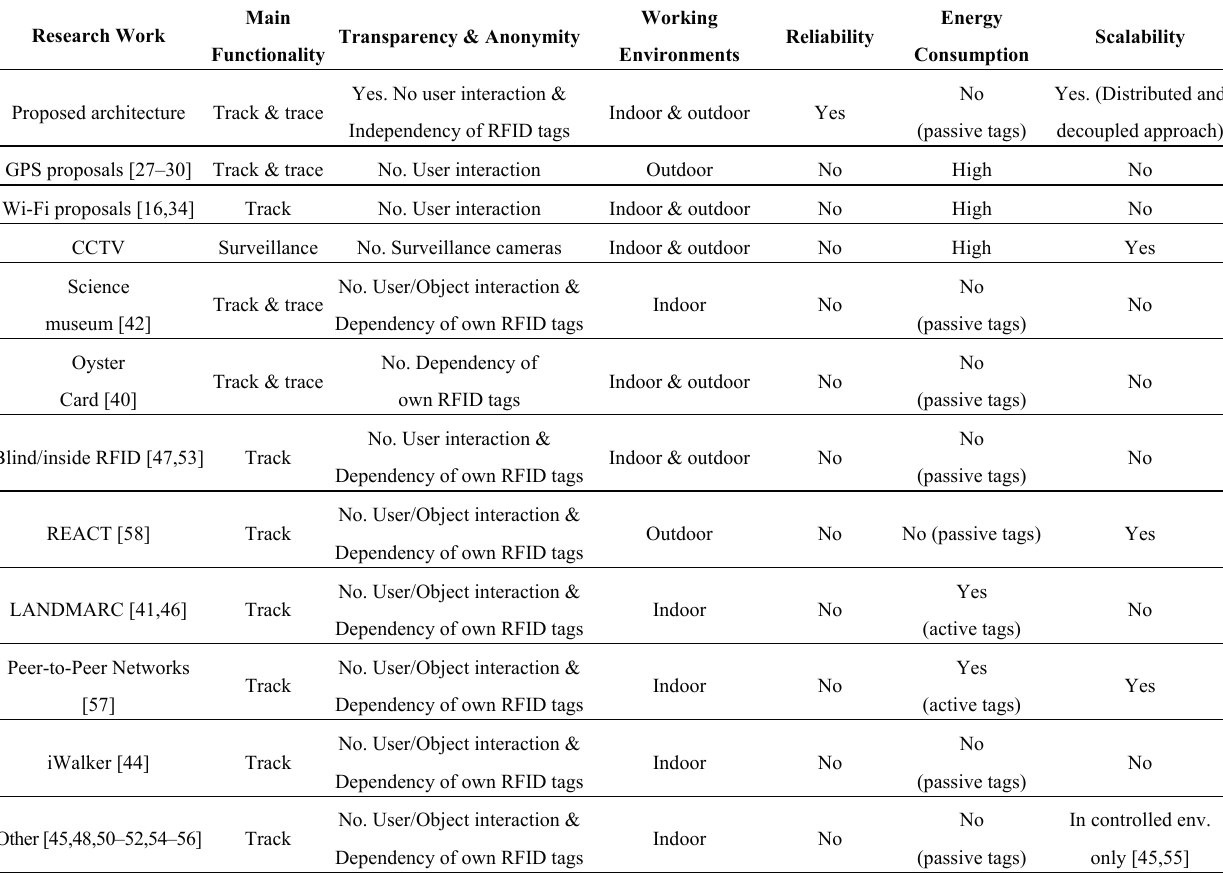
Table 3. Comparison of the obtained results between our proposal and the related